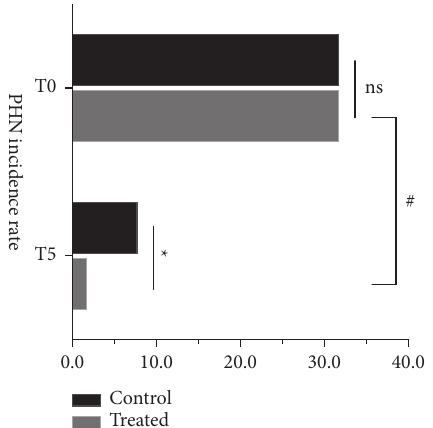
Figure 7: Comparison of the incidence of post-herpetic neuralgia in the two groups, ∗ P < 0 . 05. Compared with before surgery, # P < 0 .